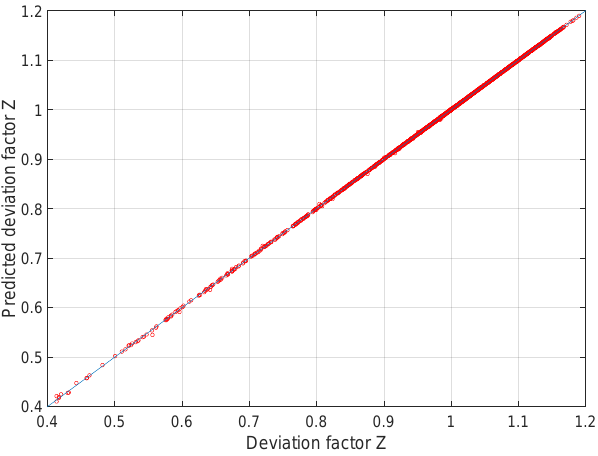
Figure 8. Performance of the TR-KRR model on the prediction dataset.